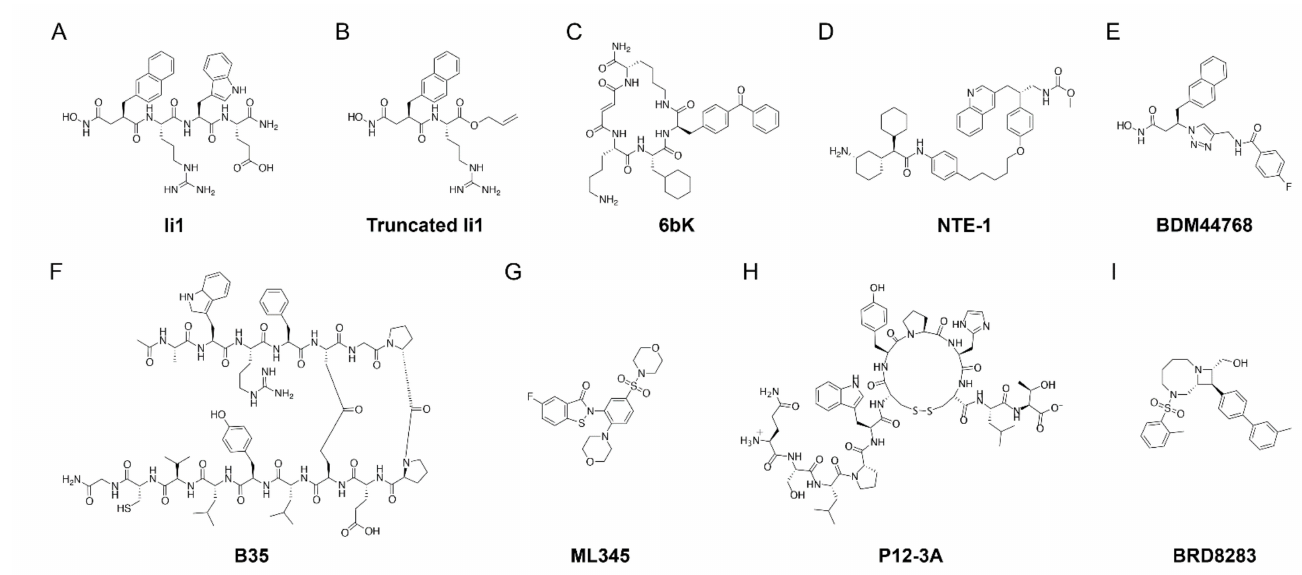
Figure 1. Structures of and common names for insulin-degrading enzyme (IDE) inhibitors.